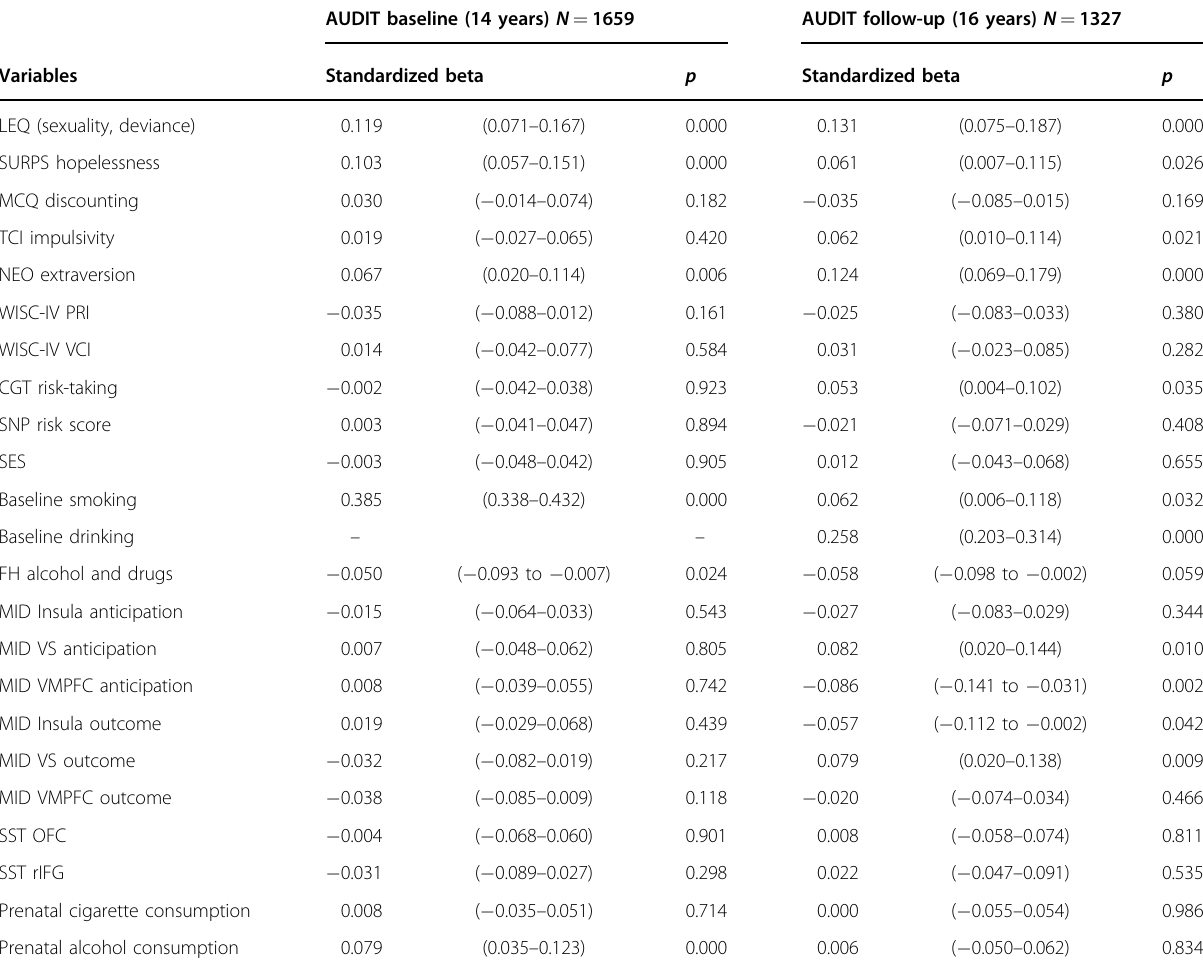
Table 2 Prediction of AUDIT at baseline and follow-up in the overall